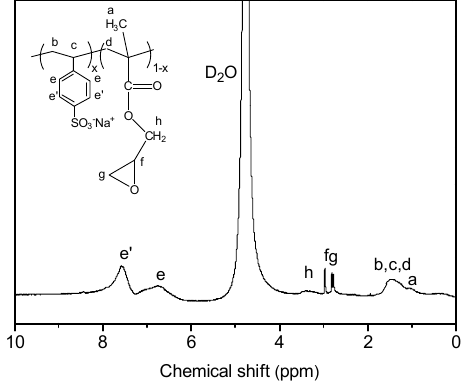
Figure 1. 1 H NMR spectrum of P(SSNa- co -GMA0.2).